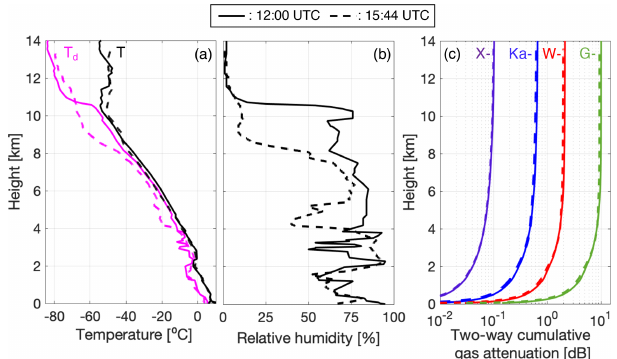
Figure 2. From sounding observations collected on 25 February 2020 at 12:00UTC at the US NWS Upton site (22km east of SBRO; solid lines) and at 15:44UTC from the SBRO (dashed lines); profile of (a) temperature (black) and dew-point temperature (magenta), (b) relative humidity, (c) two-way water vapor attenuation at X- band (purple), Ka-band (blue), W-band (red) and G-band